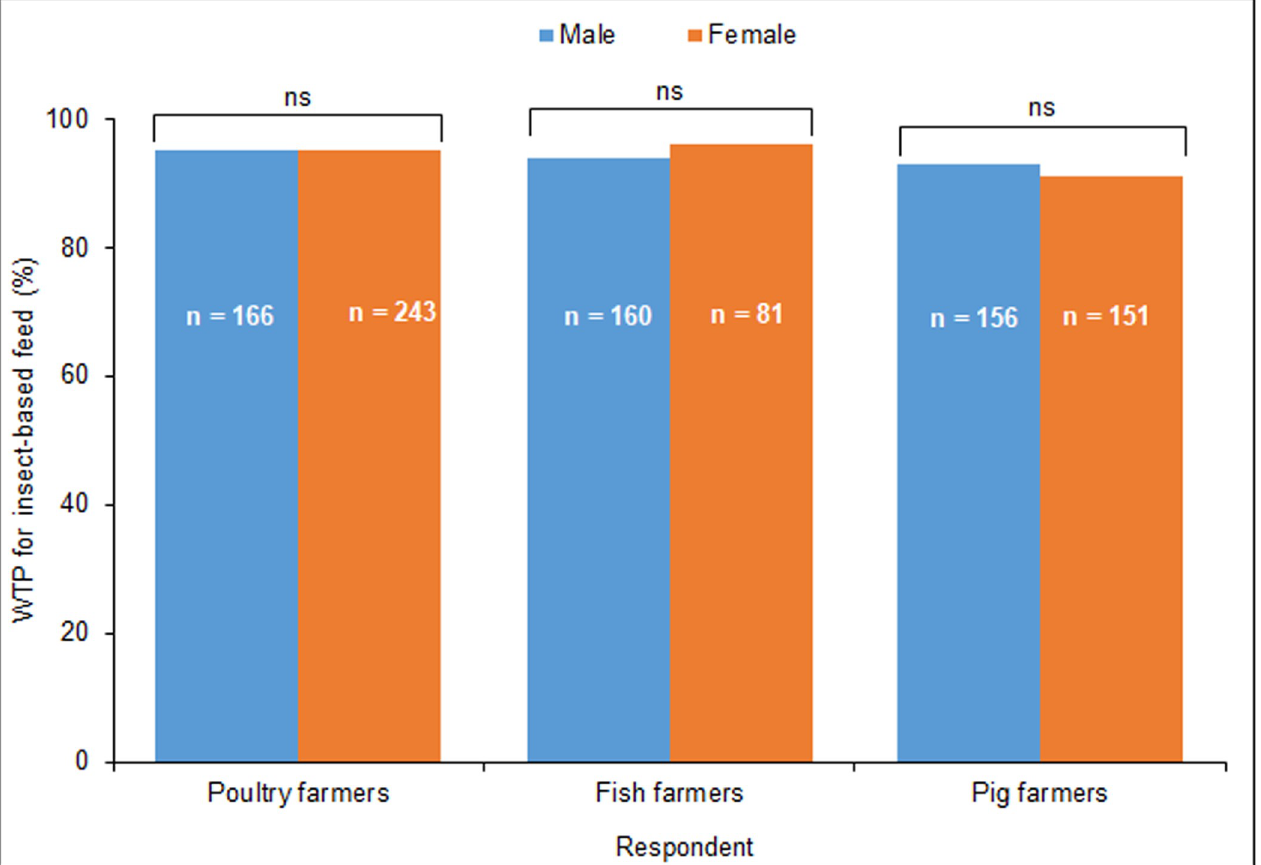
Fig 4. Percentage farmers willing to pay for insect-based feeds among male and female poultry, fish and pig farmers. Bars with “ns” are not significantly different for male and female respondents, P < 0.05, two-proportion z-test.